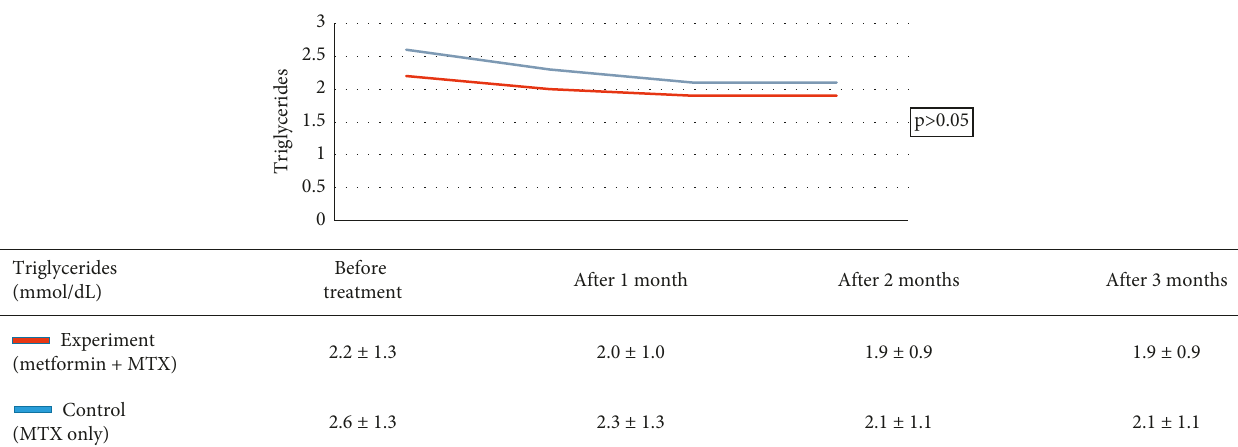
Table 8: Comparison of treatment results of two groups according to the triglycerides index.